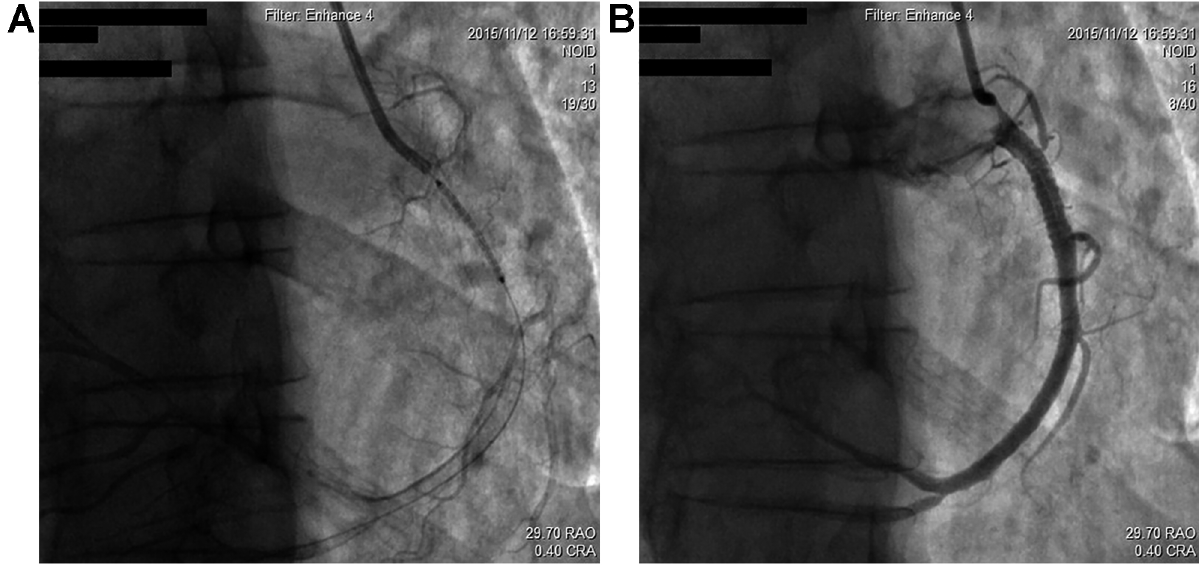
Figure 4: A drug-eluting stent was subsequently implanted at the lesion site and the intervention achieved optimal antegrade TIMI III flow without residual